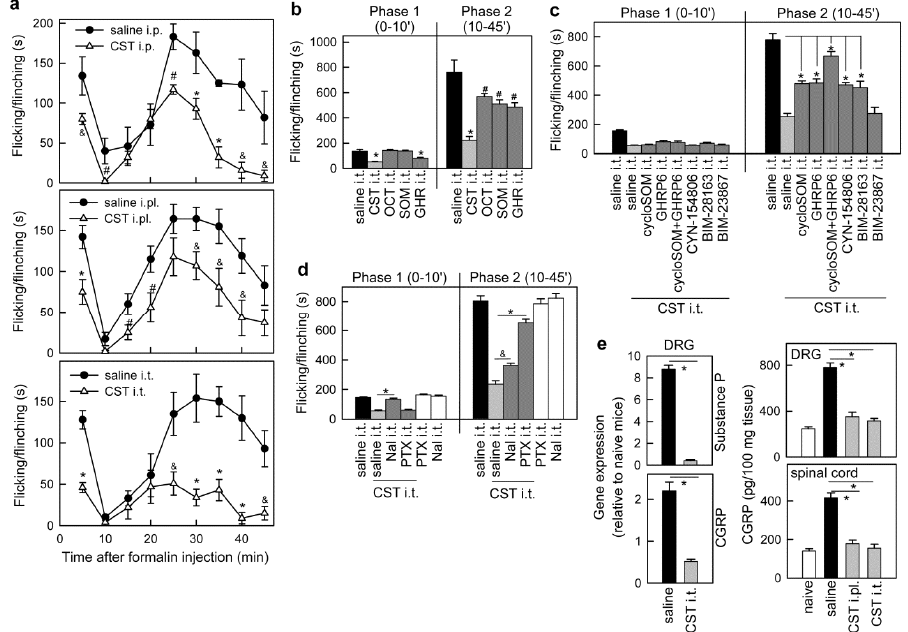
Figure 1. Peripheral and central analgesic actions of cortistatin on formalin-evoked acute pain. ( a ) Effects of central (i.t., 10 ng), peripheral (i.pl., 100 ng), or systemic (i.p., 1 µg) cortistatin (CST) injection in formalin-induced acute inflammatory pain responses. n = 6–8/group. * p < 0.0001, & p < 0.01, # p < 0.05 vs. saline-treated mice. ( b ) Comparative effects of i.t. administration of cortistatin, somatostatin (SOM), octreotide (OCT), and ghrelin (GHR) (10 ng each) in formalin-induced nocifensive responses. n = 6–7/group. * p < 0.0001, # p < 0.05 vs. saline-treated mice. ( c ) Reversal of cortistatin-mediated attenuation of formalin-induced pain behavior by antagonists against all sstr (cycloSOM), ghrelin-receptor (GHRP6 and BIM-28163), sstr2 (CYN-154806), and sstr5 (BIM-23867) administered centrally (i.t.). n = 7/group. * p < 0.0001 vs. cortistatin-treated mice. ( d ) Reversal of cortistatin-mediated attenuation of formalin-induced pain behavior by opioid-receptor (naloxone, Nal) and by pertussis toxin (PTX) administered centrally (i.t.). n = 6–7/group. * p < 0.0001, & p < 0.01 vs. cortistatin-treated mice. ( e ). Central (i.t., 10 ng) and peripheral (i.pl., 100 ng) actions of cortistatin in the expression of Substance P and calcitonin gene-related peptide (CGRP) in formalin- evoked pain determined by RT-PCR (left panel, 30 min after cortistatin injection) or by ELISA (right panel, 1 h after cortistatin injection) in ipsilateral lumbar dorsal root ganglia (DRG) and dorsal horn spinal cords. Naïve animals were used as basal controls of reference. n = 4/group. * p < 0.0001 vs. saline-treated mice. All data represent mean ± SEM. i.t., intrathecal; i.p., intraperitoneal; i.pl., intraplantar; sstr: